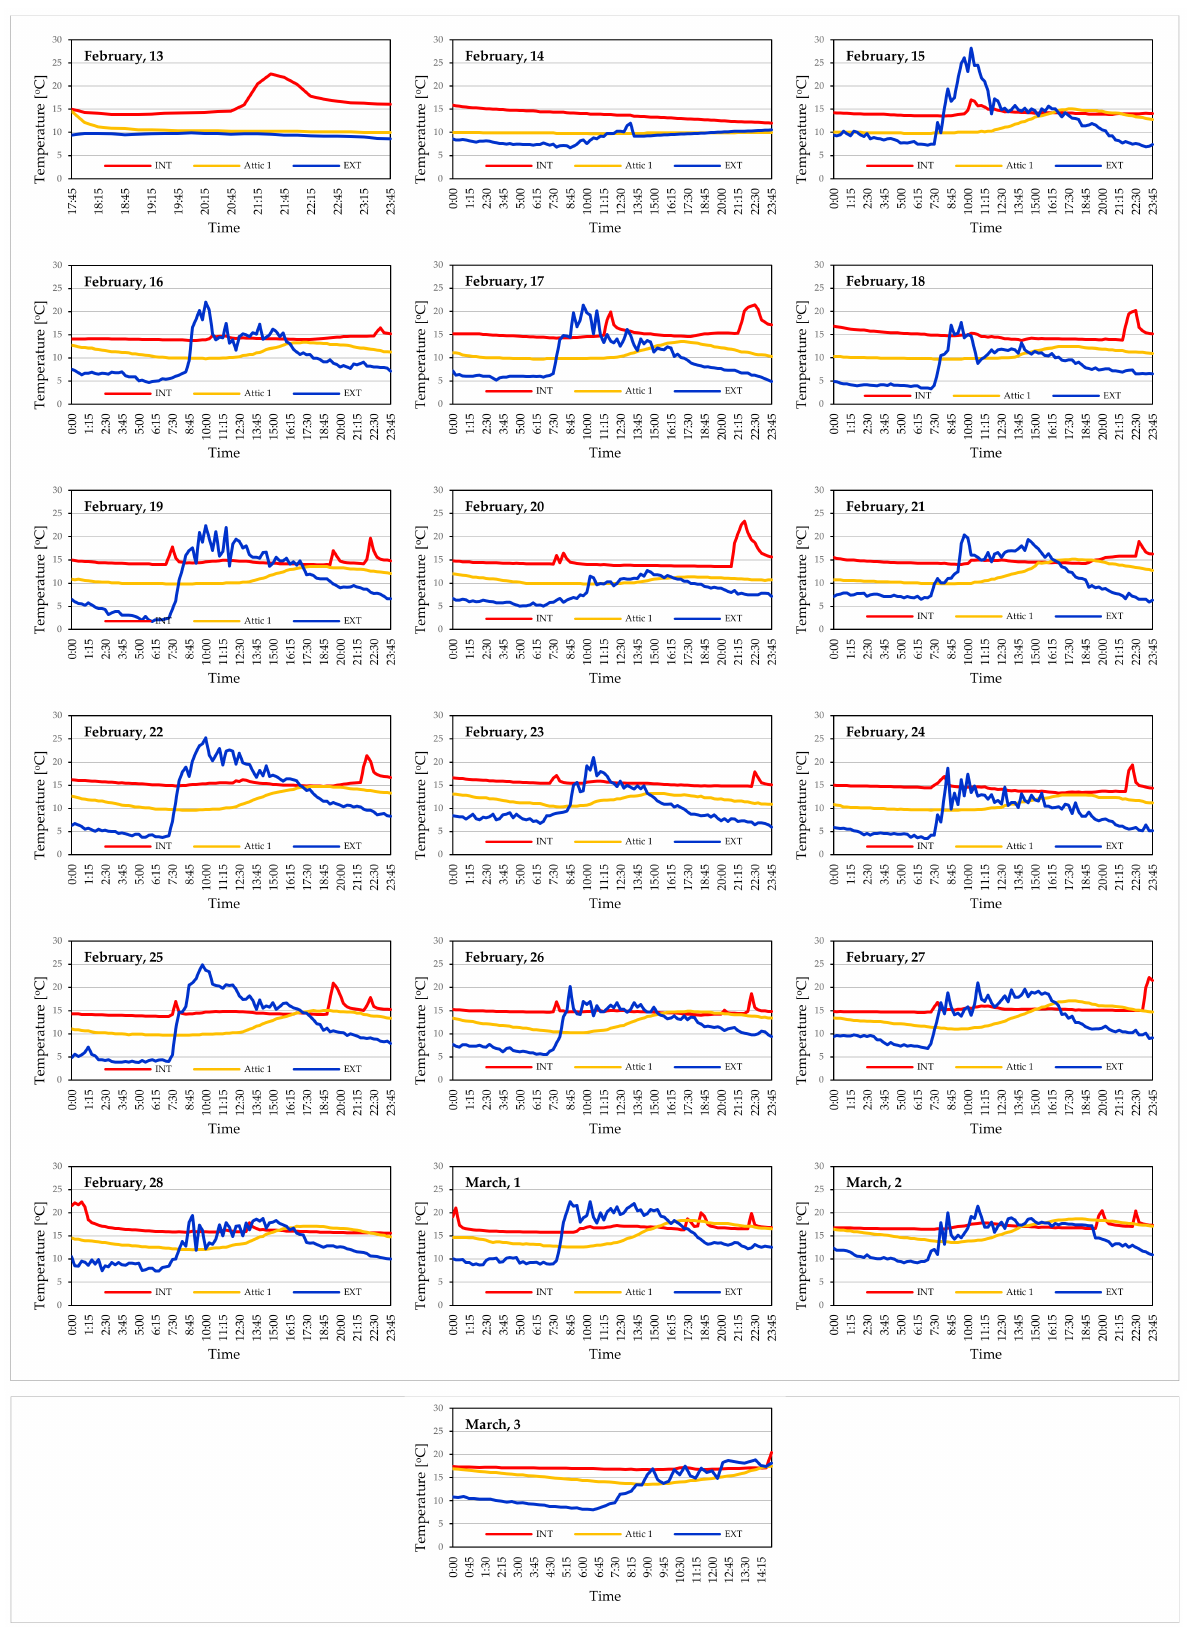
Figure 9. Daily temperature profile in Attic